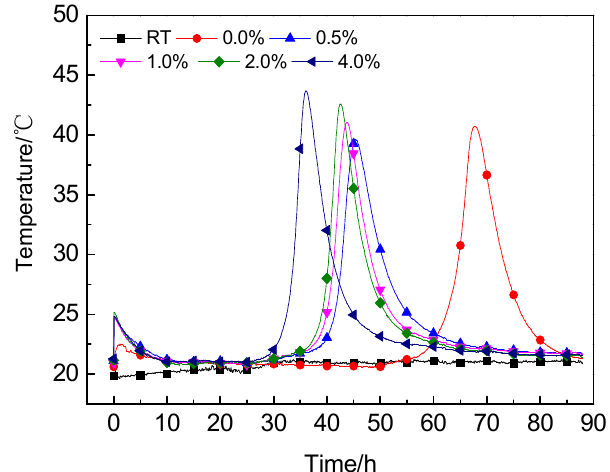
Figure 8. Effect of nano-C-S-H addition on cement hydration with 0.2 wt.% sucrose detected by semi-adiabatic calorimetry.